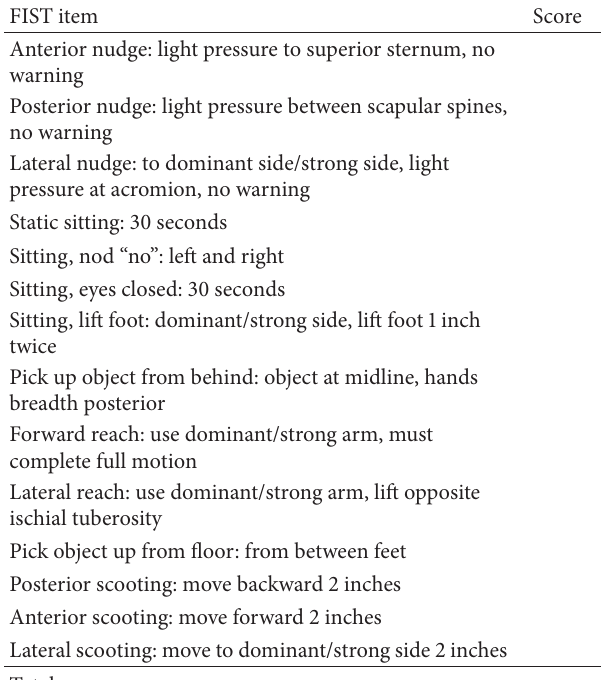
Table 1: FIST scoring sheet. Complete details about FIST adminis- tration and scoring can be found online at http://www.samuelmer- ritt.edu/fist.